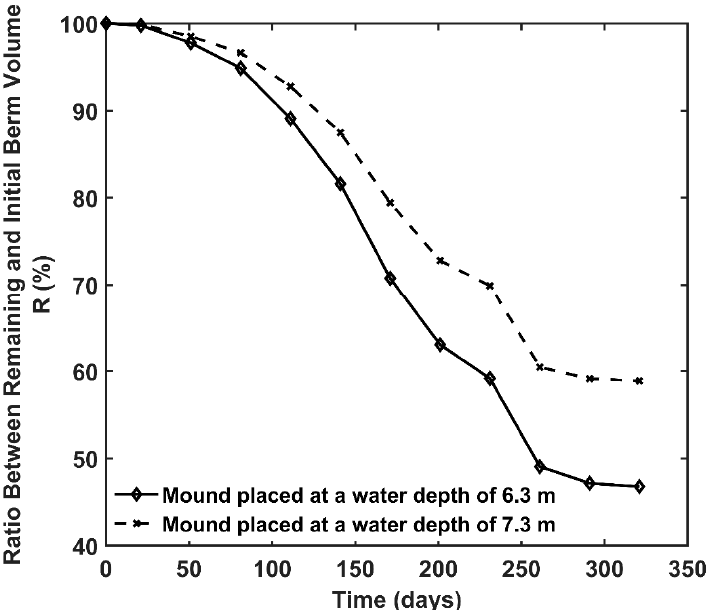
Figure 12. The ratio change between remaining and initial mound volume over time.